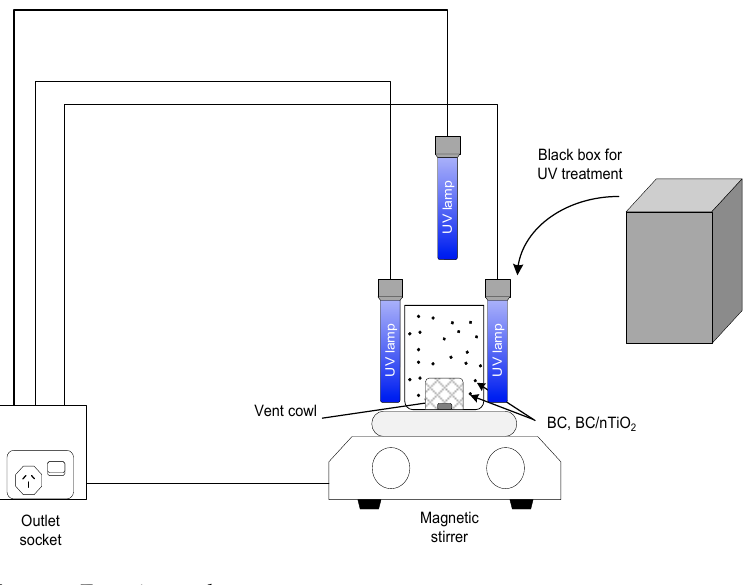
Figure 1. Experimental setup.